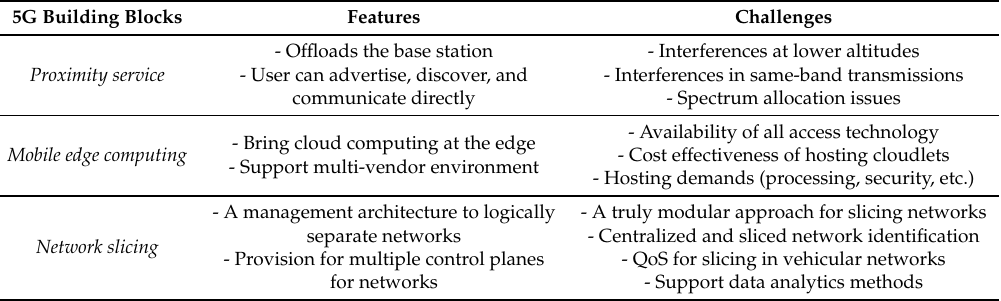
Table 3. A summary of 5G building blocks applicable to vehicular